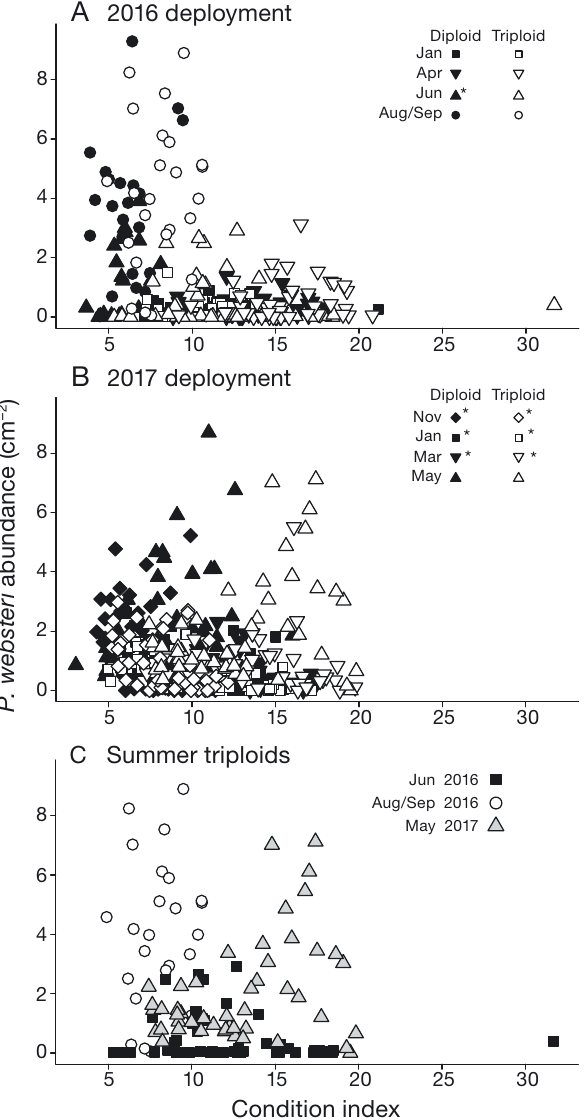
Fig. 7. Condition index versus Polydora websteri abundance for individual diploid and triploid oysters for (A) 2016 de- ployment collected in January (n = 48, n = 47), April (both n = 48), June (both n = 48), and August/September 2016 (n = 22, n = 24), (B) 2017 deployment collected in November 2016 (n = 47, n = 48), January (n = 42, n = 48), March (both n = 48), and May 2017 (n = 47, n = 48), and (C) for triploid oysters col- lected during the summer: June (n = 48), August/ September 2016 (n = 24), and May 2017 (n = 48). (*) in legend indicates significant relationship found